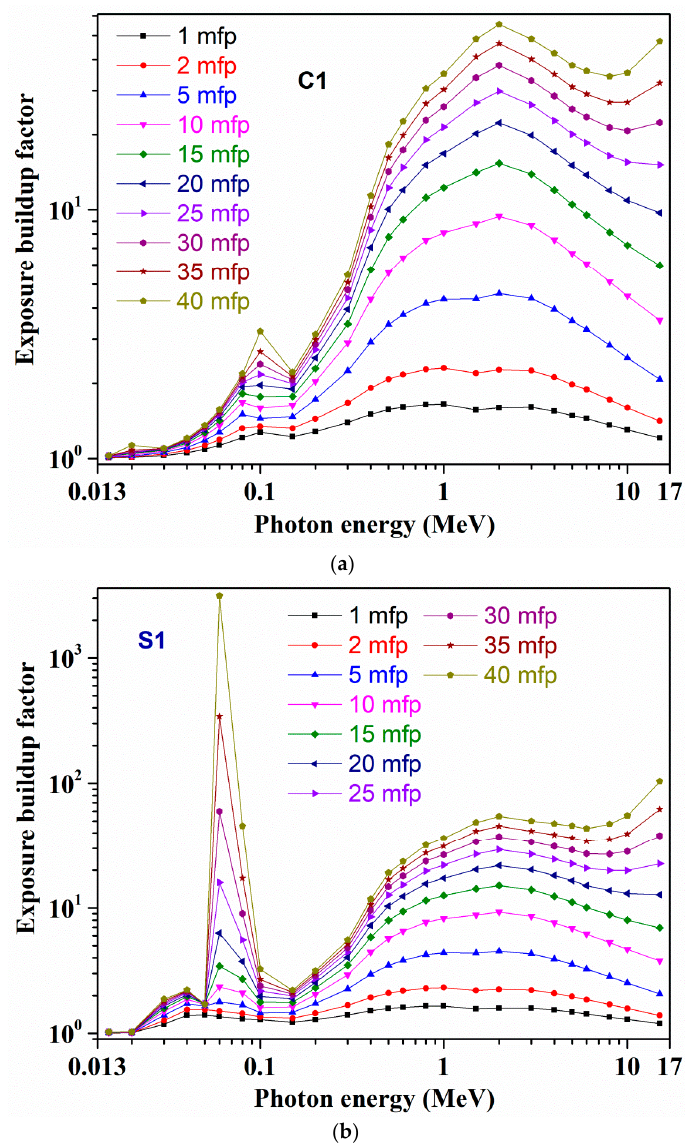
Figure 4. Variations of exposure buildup factor (EBF) with photon energy at different mean free paths for ( a ) C1 and ( b ) S1 glasses.